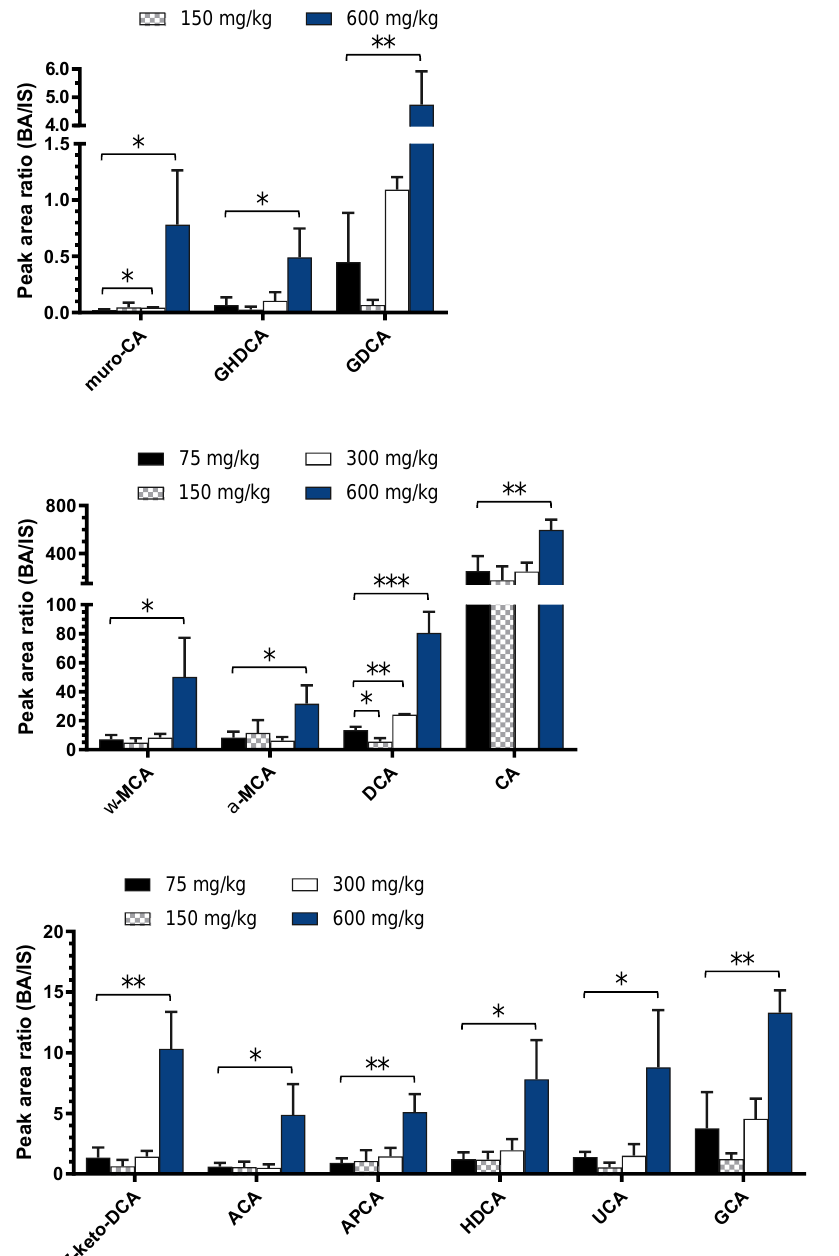
Figure 2. Peak area ratios of assigned standard bile acids having significant changes between 75 mg/kg and 600 mg/kg APAP dosing. Statistical significance is shown with p -values <0.05 (*), <0.01 (**), or <0.001 (***). Sulfate and glucuronide conjugates of bile acids were also investigated to better understand the potential perturbations in bile acid metabolism involved in drug-induced liver injury. These are two phase II conjugation reactions that increase the solubility of bile acids, promoting their elimination in urine or bile [7,8]. Putative conjugates of the bile acids were assessed by accurate mass filtering. Their structures, however, were not confirmed, and the names assigned here correspond to a standard BA identified within the standard mix, however it can be any isomer of that